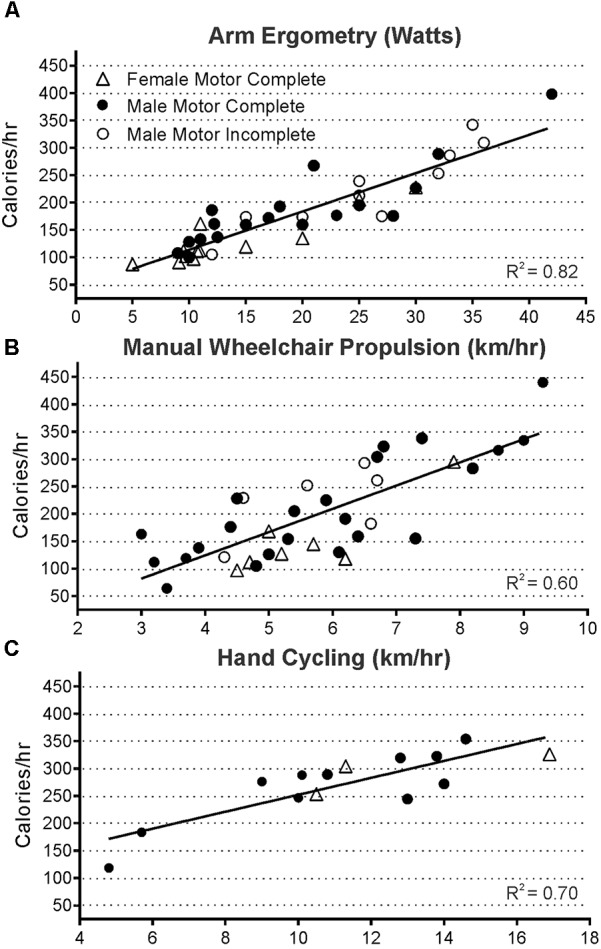
Steady state energy use and power output were well correlated during all modes of exercise measured in 125 exercise trials of arm ergometry (A, p < 0.0001, n = 70 trials), wheeling (B, p < 0.0001, n = 39 trials), and hand cycling (C, p = 0.0002, n = 16 trials). Data from all three groups were pooled since the slopes of each group’s line were not significantly different (male and female motor complete, and male motor incomplete).